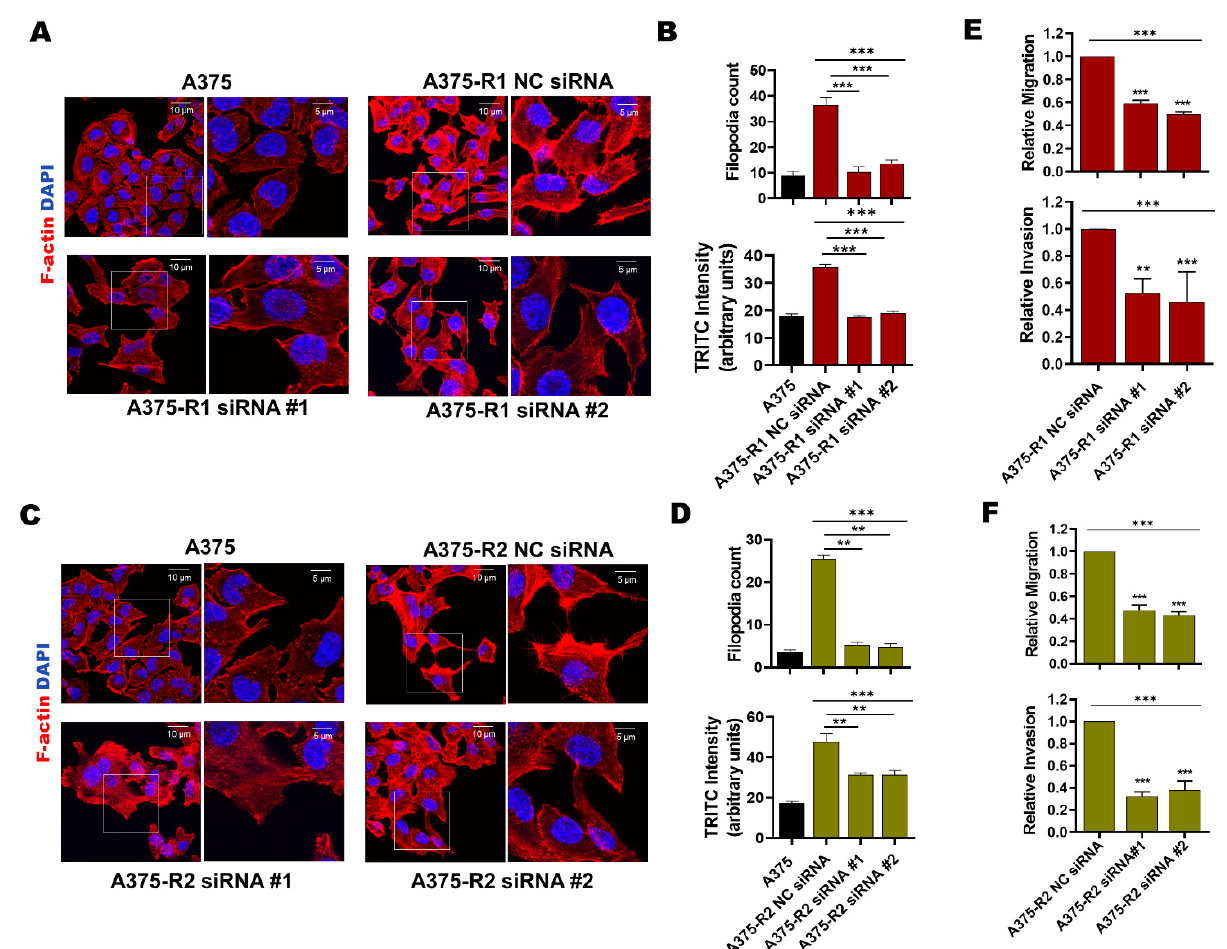
Figure 5. Knockdown of MARCKS is sufficient to induce morphological changes and reduce the migratory and invasive capacities of BRAFi-R melanoma cells. ( A , C ) A375-R1 ( A ) and A375-R2 ( C ) melanoma cells were transfected with negative control siRNA (NC; 50 nM) or either of two different MARCKS-targeting siRNAs (50 nM), after which they and A375 cells were stained with phalloidin-TRITC (F-actin) and DAPI as described in Section 2. For each image, a region of interest (marked with a white box) is further magnified and placed adjacent to its respective low magnification image. The scale bar in the lower and higher magnification images represent 10 and 5µm, respectively. ( B , D ) Graphs showing the mean TRITC fluorescence intensity and the number of filopodia-like pro- trusions in A375, A375-R1 ( B ), A375-R2 ( D ) cells transfected with control siRNA (NC; 50 nM) or either of two different MARCKS siRNAs (50 nM); both parameters were measured with NIH ImageJ software. The results are given as the means ± SEMs. ( E , F ) Graphs showing the migration and inva- sion capacities of A375-R1 ( E ) and A375-R2 cells ( F ) transfected with control siRNA (NC; 50 nM) or either of two different MARCKS siRNAs (50 nM). Migration and invasion were analyzed by transwell-based assays as described in Section 2. The numbers of migrated and invaded cells were determined using NIH ImageJ software, and the data were normalized to those in NC siRNA-trans- fected cells and are given as the mean ± SEM of 4 independent experiments. Statistical significance was estimated using ANOVA with Dunnett’s ( B , D ) and Tukey’s ( E , F ) post hoc tests for multiple comparisons; ** p < 0.01, *** p < 0.001. Next, we employed a zebrafish xenograft model to validate the role of MARCKS in the metastatic potential of BRAFi-R A375-R2 cells in vivo (Figure 6A). Previous studies have shown the advantages of monitoring and studying the metastatic spread of cancer cells, including melanoma cells [38–40]. We first transfected A375-R2 melanoma cells with either a negative control or MARCKS-targeting shRNA plasmid. The increases in the lev-